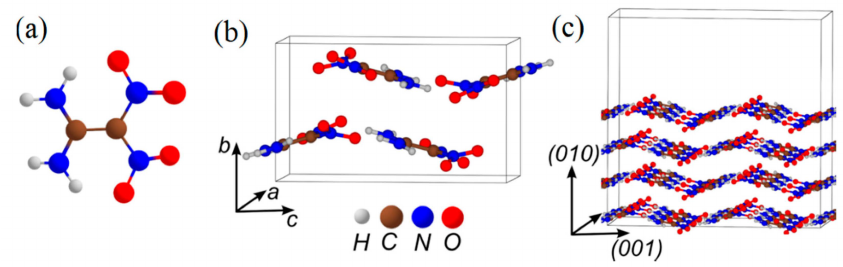
Figure 8. The structure of ( a ) a DADNE molecule; ( b ) a DADNE ideal crystal; and ( c ) a model supercell fragment of the (010) surface.